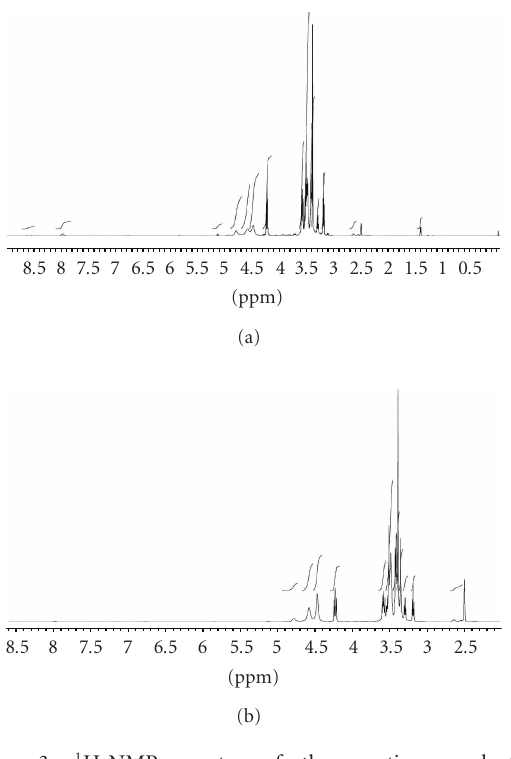
Figure 3: 1 H-NMR spectra of the reaction product of BHEOA:EC:(a) 1 :4 at 140 ◦ C, (b) 1: 6 in the presence of 0.06mole K 2 CO 3 /mole OA at 160 ◦ C.